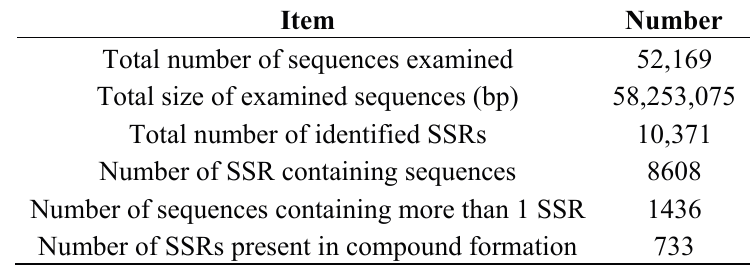
Table 1. Summary of the EST-SSRs identified in the transcriptome